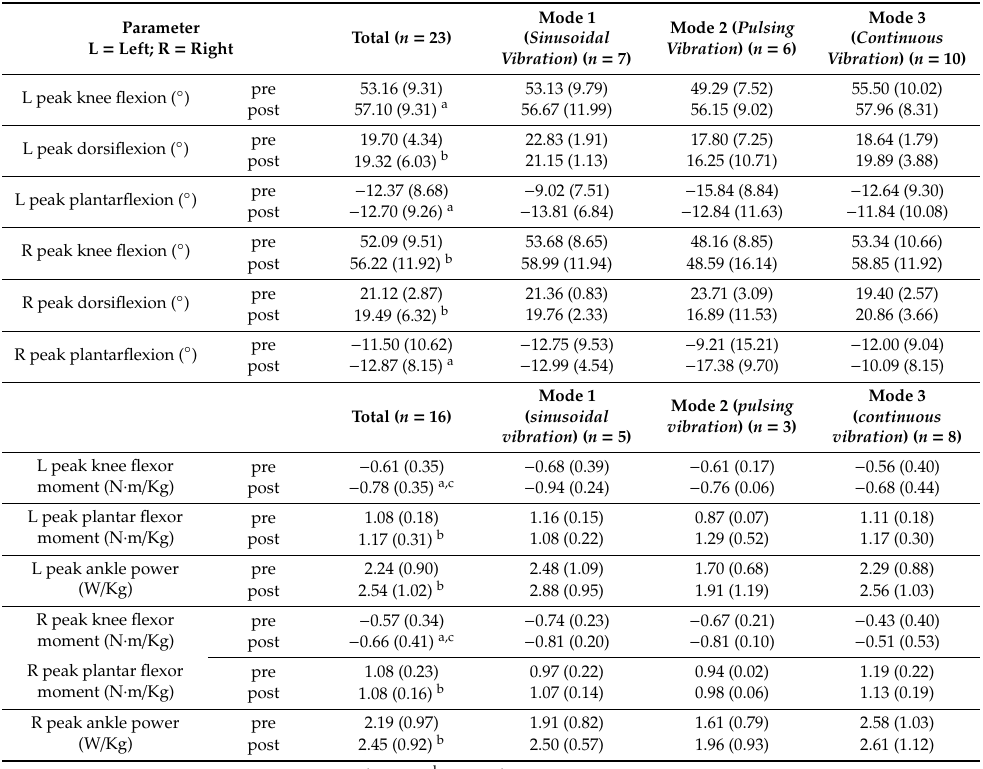
Table 3. Mean (std) in kinematic and kinetic parameters for all participants and for the three vibration mode